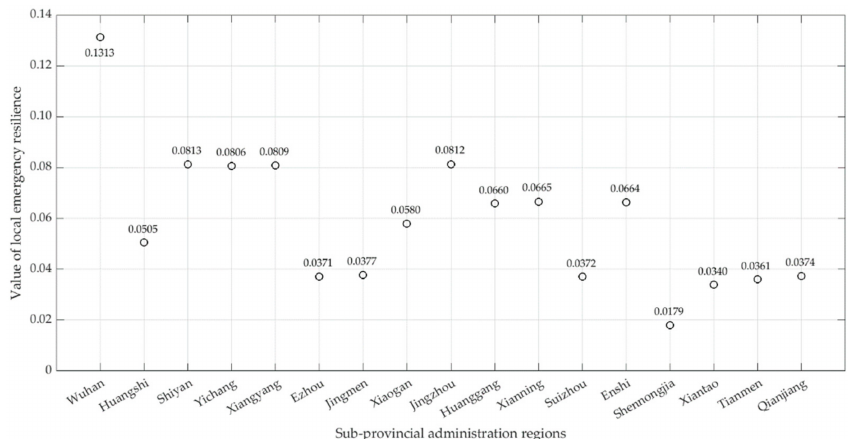
Figure 7. Value of the local emergency